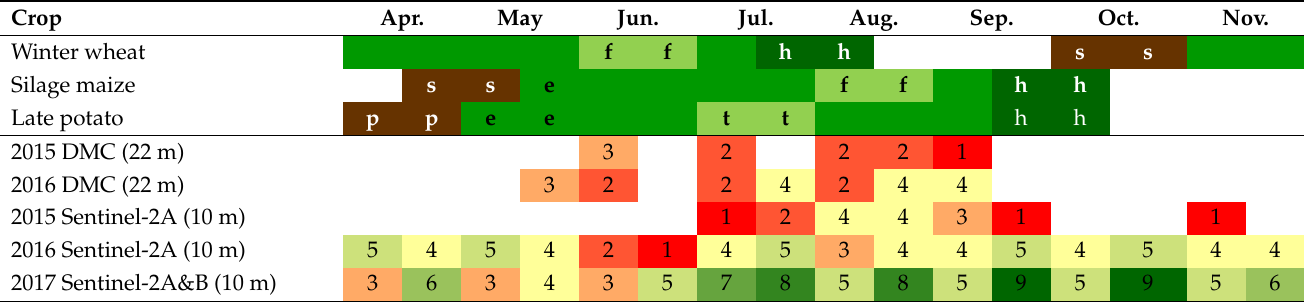
Table 1. Cropping calendar for winter wheat, silage maize, and late potato, and number of